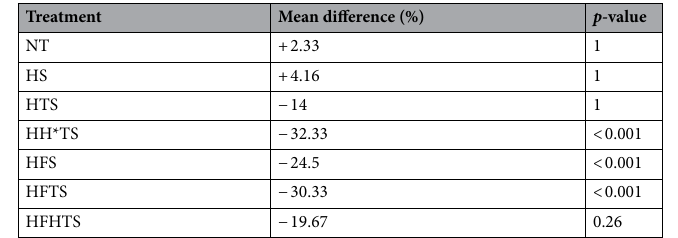
Table 5. The change in the mean N. trichotoma cover (%) from the first sampling period to the fifth sampling period for the treatments. The negative numbers signify a reduction of N. trichotoma cover, while positive numbers signify an increase in cover. Differences were considered significant when p <